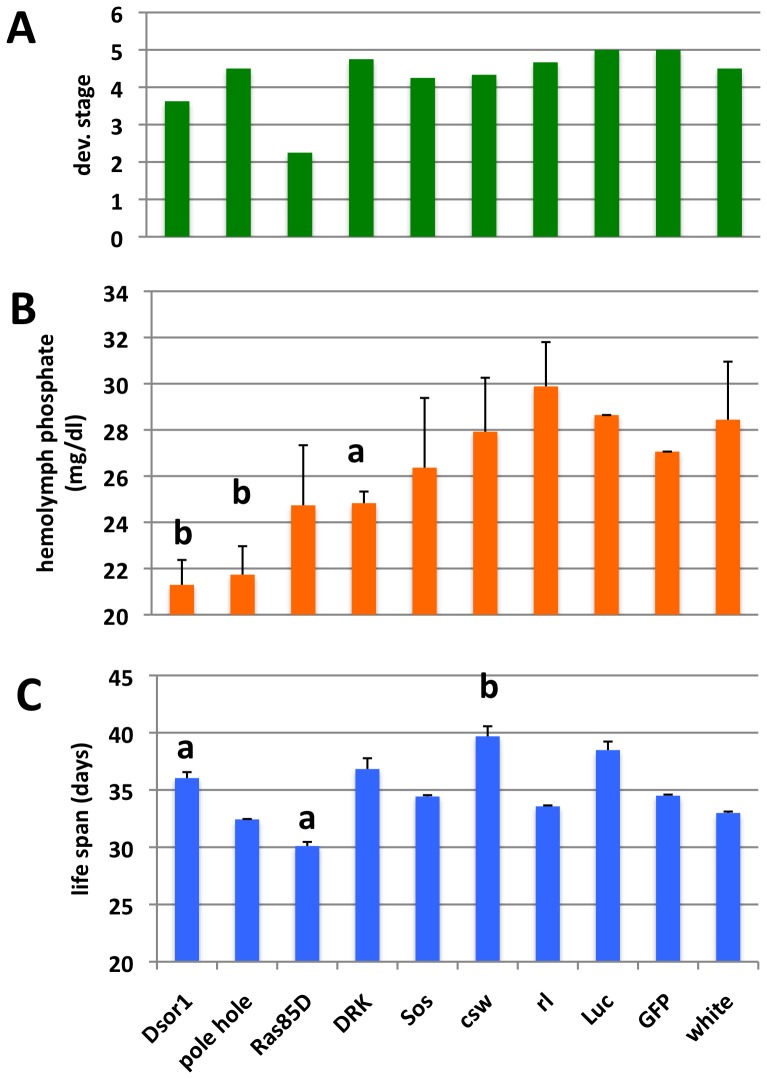
RNAi-mediated inhibition of MAPK-signaling in vivo decreases hemolymph phosphate. A:The most advanced developmental stage with induced knockdown was scored on standard medium (1 = embryonic, 2 = first and second instar larva, 3 = third instar larva, 4 = pupal lethal, 4.5 = developmental delay, adult, 5 = adult). B: hemolymph phosphate concentration of young adult females cultured at 29°C for five days, and C: median life span of adult males cultured at 29°C on standard medium (see also Table S1). a: p<0.05, b: p<0.007 vs. Luc/GFP/white controls. P<0.017 was used to test for multiple comparisons between three treatments.